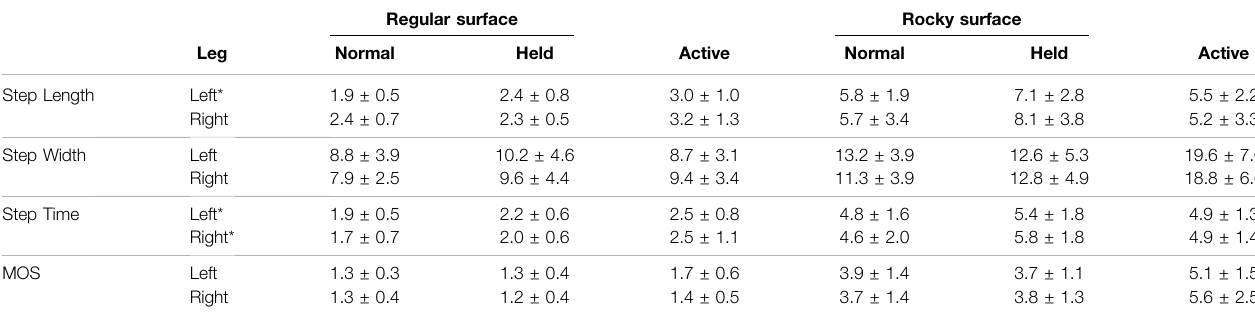
TABLE 4 | Coef fi cient of Variation of step length, step width and step time, as well as the standard deviation of the margin of stability (x10 − 2 cm) for both heel strikes according to surface type and arm swing